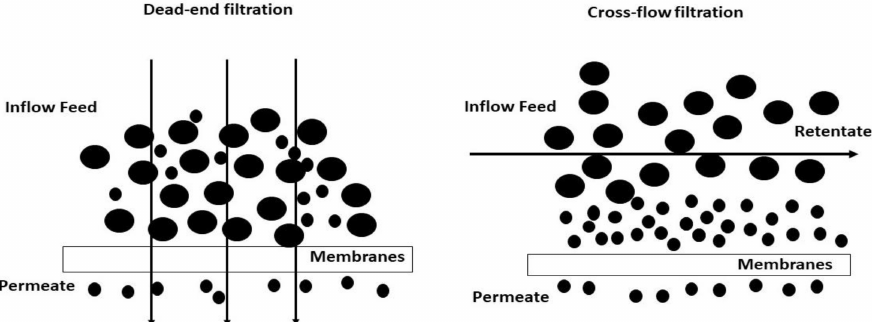
Figure 2. Mechanism of cross-flow filtration and dead-end filtration